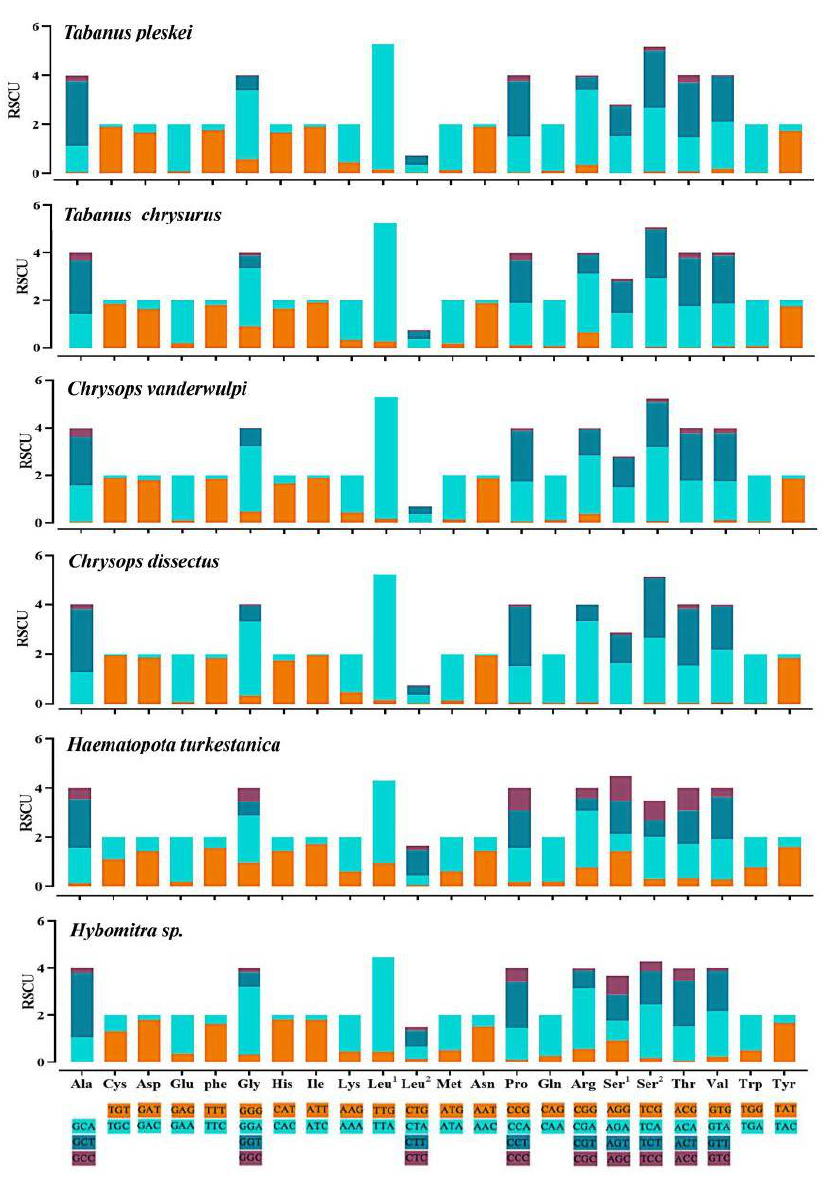
Figure 5. Relative synonymous codon usage (RSCU) of the obtained mitogenomes. RSCU values are represented on the y-axis, and the Aedini tride codons of their respective amino acids represented on the x -axis.